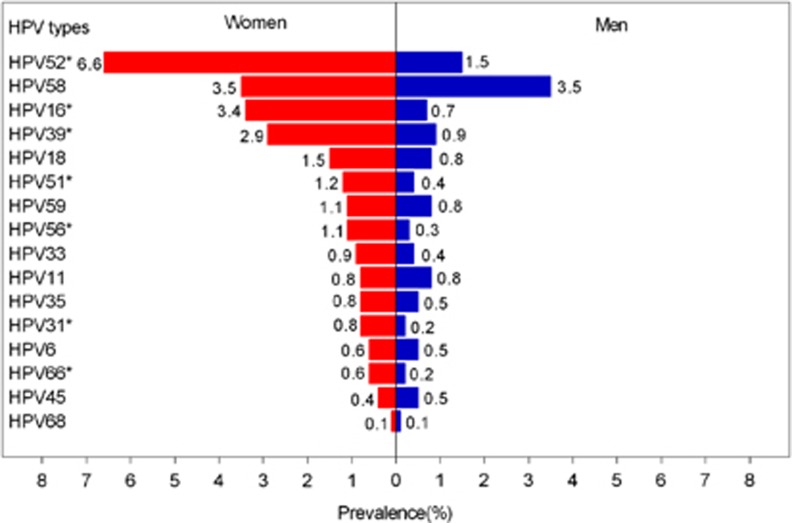
Type special HPV infection distribution in women and men at study enrollment. *Significant differences between women and men at P <0.05 with Pearson's χ2-test, correction for the χ2-test or the Fisher exact test. Human papillomavirus, HPV.